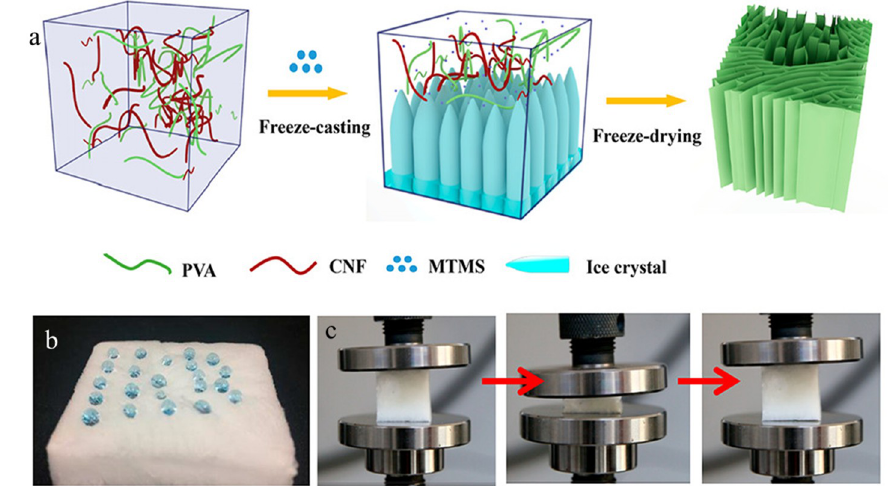
Figure 13. ( a ) A schematic illustration of fabricating hydrophobic cellulose aerogels. ( b ) A picture showing water droplets on the aerogels. ( c ) Pictures showing recovering of an aerogel from compression. Adapted from [152] with permission, copyright the American Chemical Society, 2019.